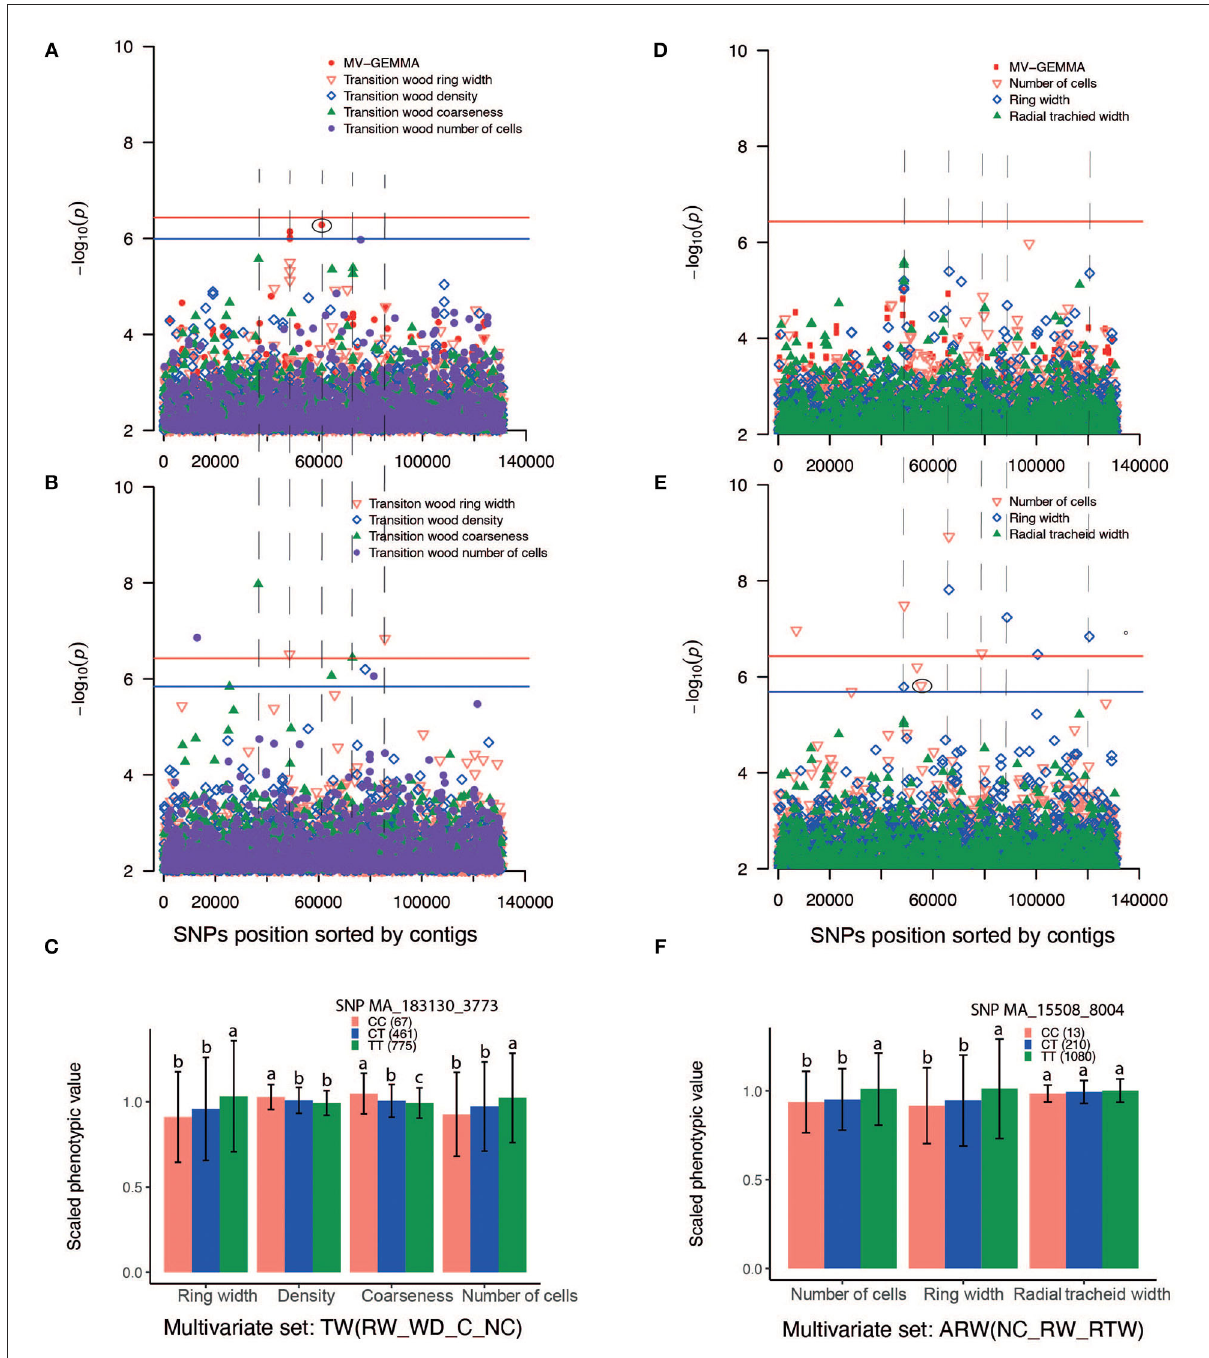
FIGURE6 Manhattan plots comparing GEMMA univariate (UV-GEMMA), multivariate (MV-GEMMA), and BLINK GWAS for wood traits measured in Picea abies . P -values are converted to –log10 ( P -value). Single-nucleotide polymorphisms (SNPs) above the red lines passed the Bonferroni correction test ( P < 3.7 × 10 − 7 ). SNPs above the blue line passed false discovery rate (FDR) ( P < 0.05) for the multivariate set in (A) , transition wood of coarseness in (B) , and the number of cells in (E) (blue line was only shown for the interesting traits and there is SNP passing FDR P < 0.05). Only SNPs with P < 1 × 10 − 2 are plotted. (A) Manhattan plot based on multivariate (MV-GEMMA) and univariate (UV-GEMMA) analysis of four traits in the transition wood [ring width, wood density, coarseness, and the number of cells, labeled as TW(RW_WD_C_NC)]. (B) Manhattan plot based on univariate model BLINK only for the same four traits in the transition wood. (C) Allelic effects of SNP MA_183130_3773 on the four traits in the transition wood. CC, CT, and TT are genotypes of the associated SNP. The number in parenthesis is the number of individuals for each of genotypes CC, CT, or TT. (D) Manhattan plot based on multivariate (MV-GEMMA) and univariate (UV-GEMMA) analysis of three traits in the annual ring wood [number of cells, ring width, and radial tracheid width, labeled as ARW(NC_RW_RTW)]. (E) Manhattan plot based on univariate model BLINK only for the same three